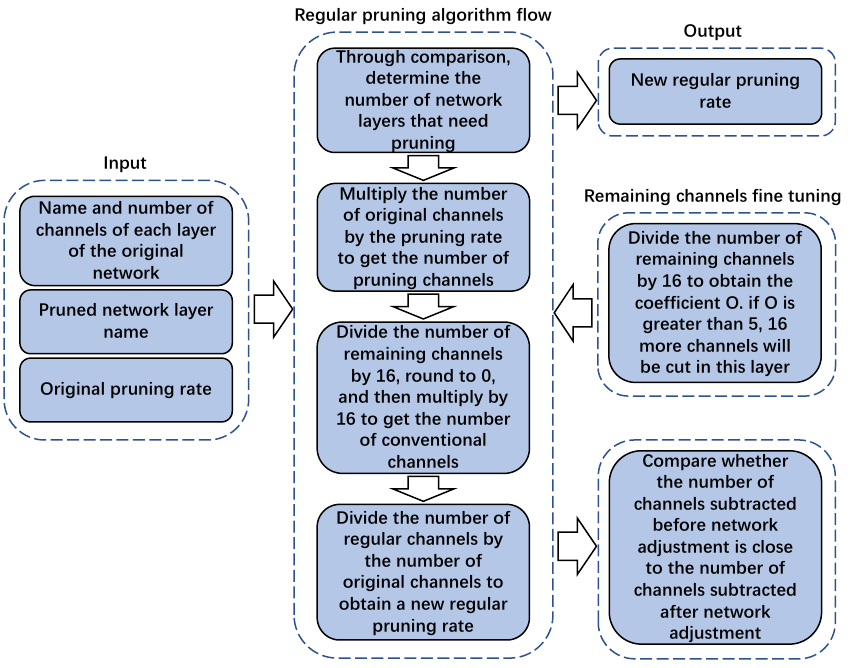
Figure 6. Process of adjusting the pruning rate using the conventional pruning